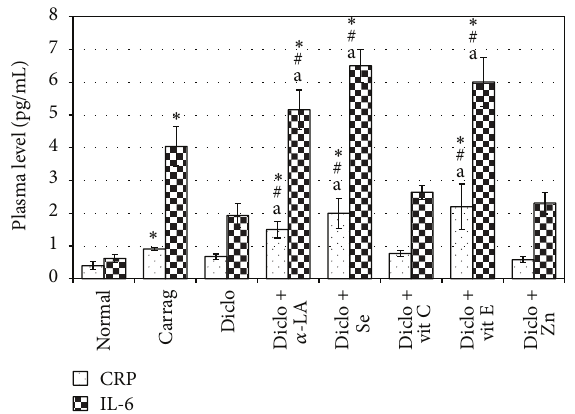
Figure 2: Effect of combinational treatments on plasma CRP and IL-6 levels. All rats were provided daily oral doses of diclofenac in combination with selenite, Vit C, Vit E, or ZnSO 4 ; 𝛼 -LA (50 mg/kg) was administered IP. Doses were the same as outlined in Figure 1 legend. ∗ # Value is significantly different from normal control and carrageenan-onlyrats,respectively( 𝑃 < 0.05 ). a Valueissignificantly different from that of diclofenac-treated hosts ( 𝑃 < 0.05